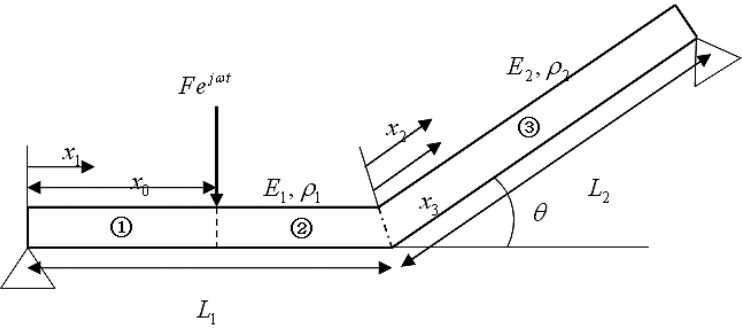
Fig. 10. The coupled finite Timoshenko beam structure joined at an arbitrary angle for